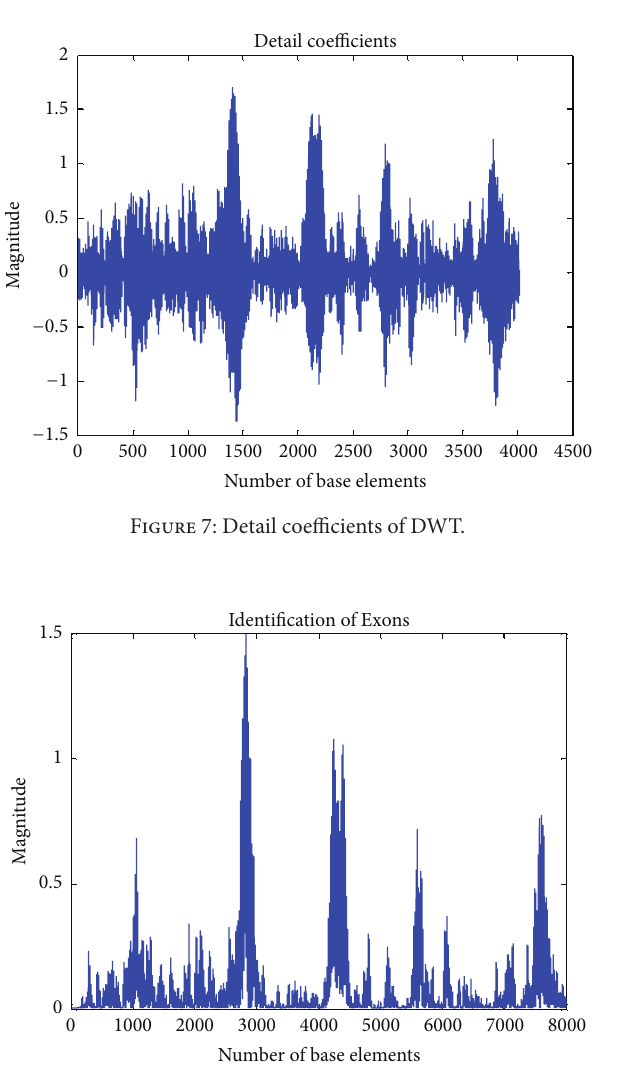
Figure 8: Output of the proposed system.